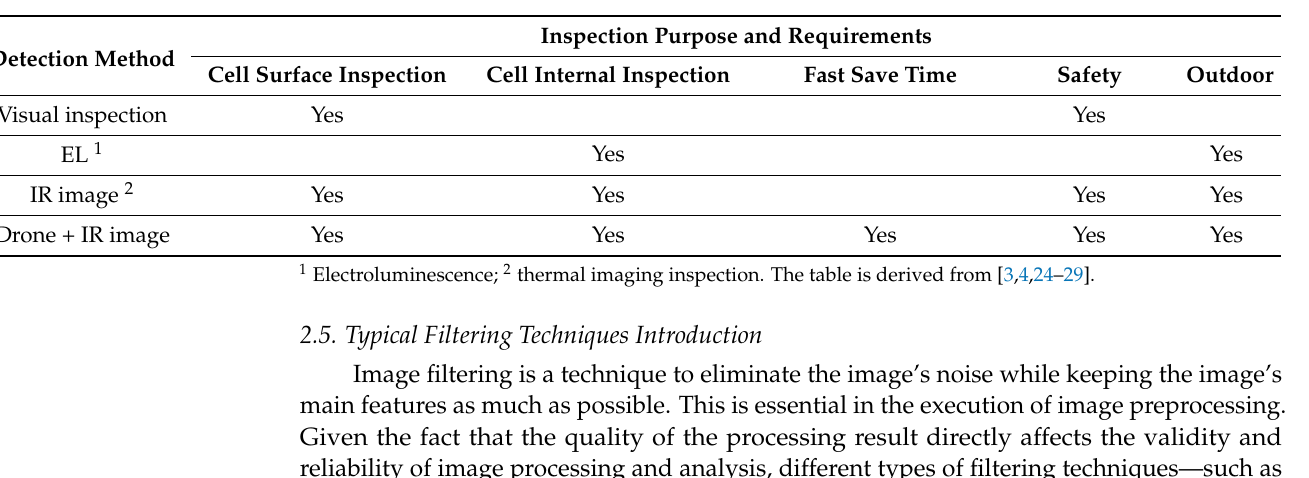
Table 3. Comparison of solar module detection methods and purposes.